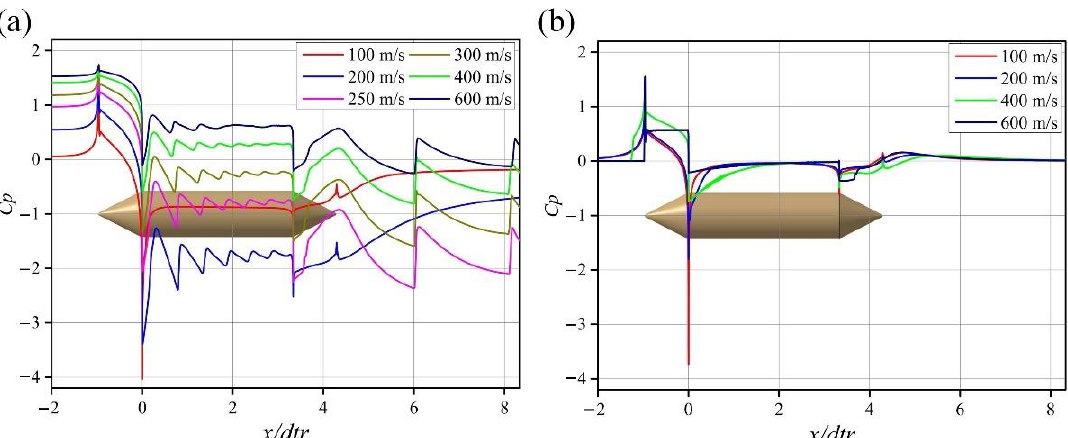
Figure 9. The distribution of pressure coefficient along the axis of the tube and the longitudinal line on the train surface: ( a ) 0.1 atm ETT system, ( b ) 1 atm open system.